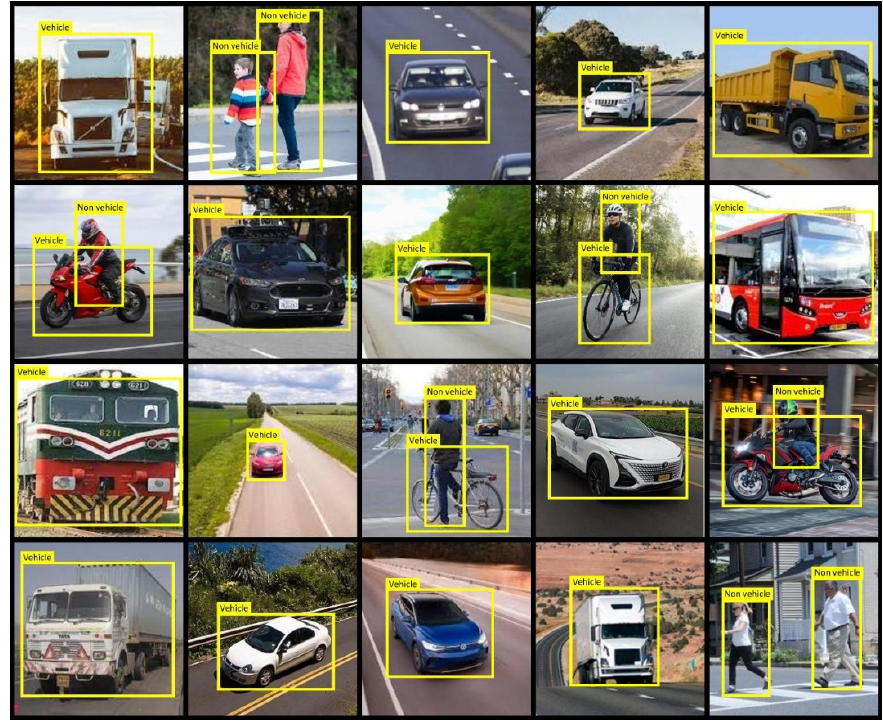
Figure 7. Results of the proposed model’s detection by using the Kaggle Vehicle dataset.